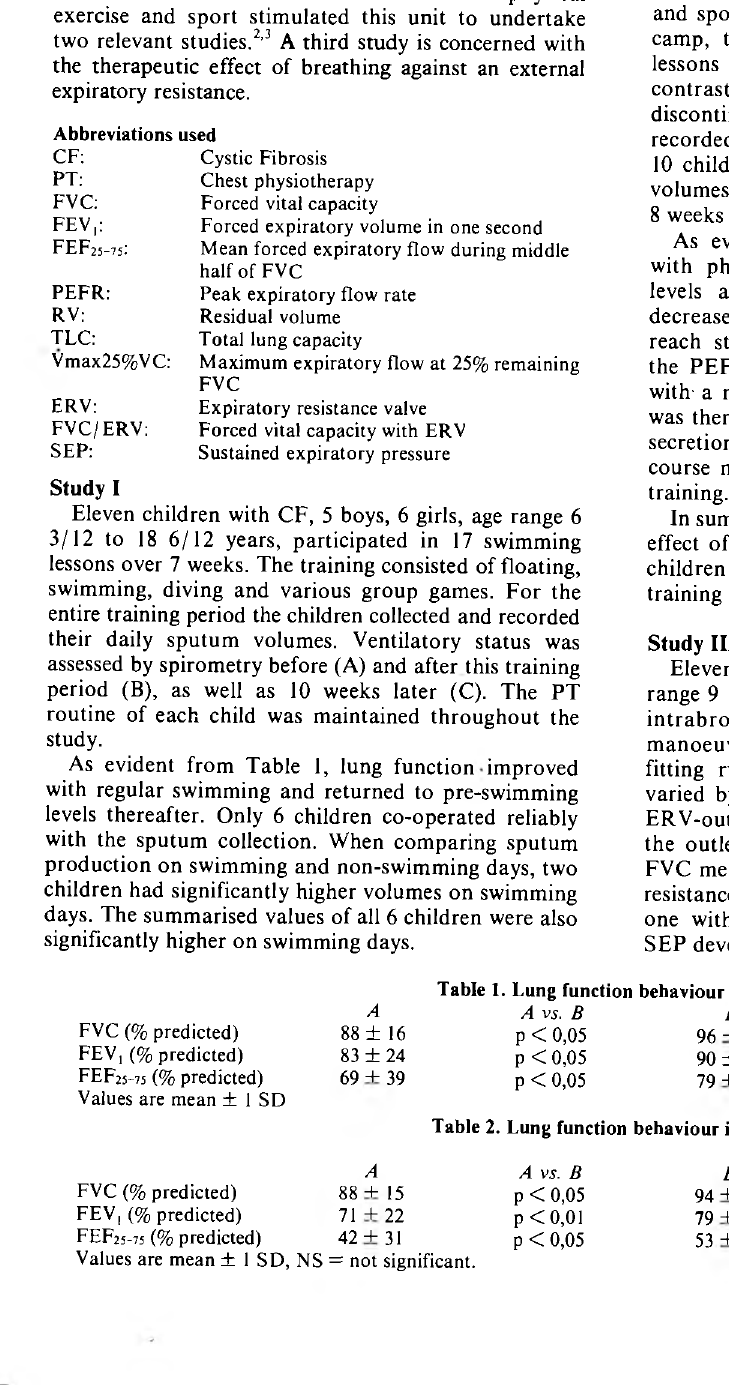
Values are mean ± 1 SD, NS = not